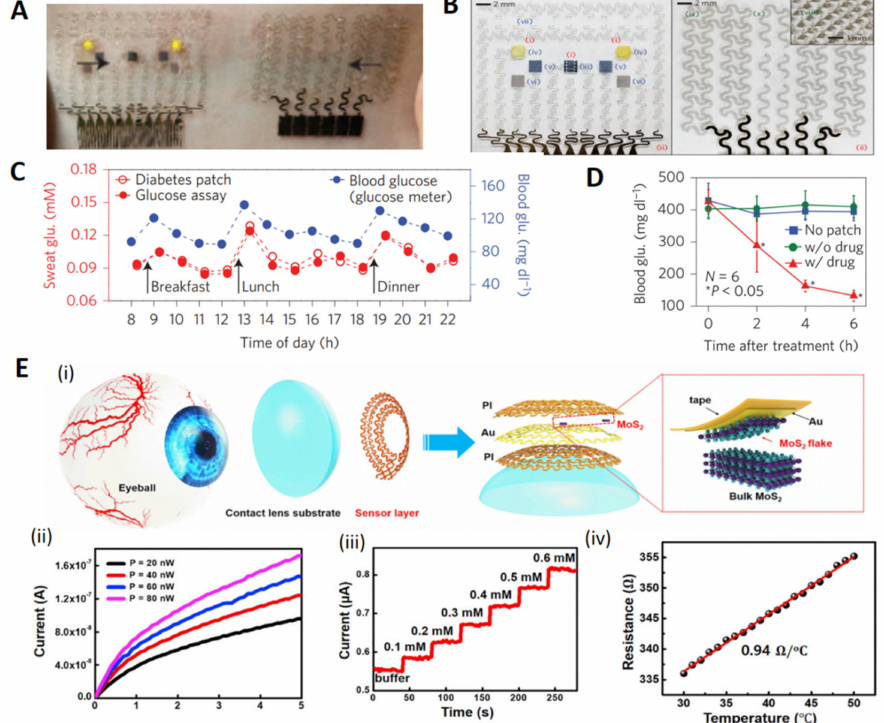
Figure 5. Several highly integrated wearable sensors based on 2D materials. ( A ): Optical camera images of the diabetes patch laminated on human skin. ( B ): Schematic diagram of a GP-hybrid electrochemical unit consisting of electrochemically active and soft functional material (xi), gold- doped graphene (xii), and serpentine gold mesh (xiii) from top to bottom. ( C ): One-day monitoring of human sweat and blood glucose concentrations in human sweat and blood. ( D ): Comparison of blood glucose concentrations in db/db mice in the treatment group (with drug) and control group (without patch and without drug) when used on diabetic mice [128]. Copyright 2018, Springer Nature. ( E ): (i) Schematic diagram of the different layers of the smart contact lens structure attached to the eye. The dashed area highlights the gold-mediated mechanical peeling of a single layer of MoS 2 . (ii) Leakage source characteristics of the photodetector at different light intensities. (iii) Time vs. current curves based on changes in glucose levels. (iv) Resistance versus strain of the temperature sensor at different temperatures [129]. Copyright 2020,